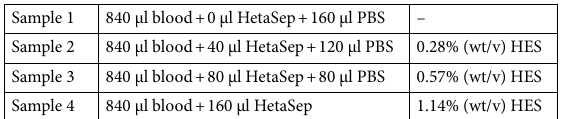
Table 1. Blood samples used in experiments to determine RBC